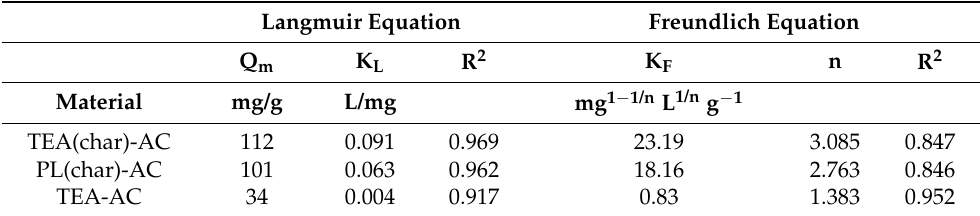
Figure 7. Isotherms of the synthesized AC samples at 25 °C. Table 2. Equilibrium parameters for the adsorption of PRM onto AC samples.